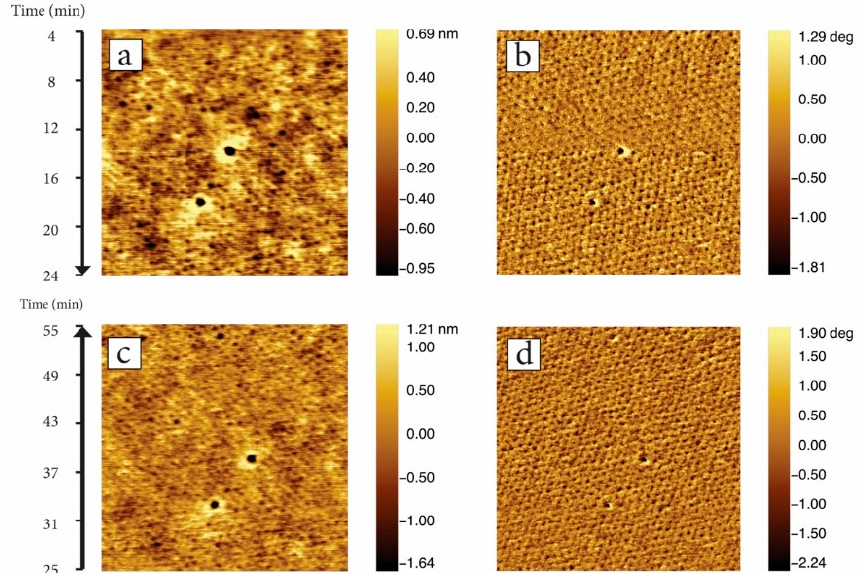
Figure 11. In-situ SFM topography ( a , c ) and phase ( b , d ) images (1 μ m × 1 μ m) during washing with ultra-pure water for 55 min. The recording started 4 min. after immersing the ultra-thin film in ultra-pure water. The trace scan ( a , b ) proceeded from top to bottom and the retrace scan ( c , d ) in the opposite from bottom to top. UV cleaved the polymer film for 4 h prior to the in-situ recording.